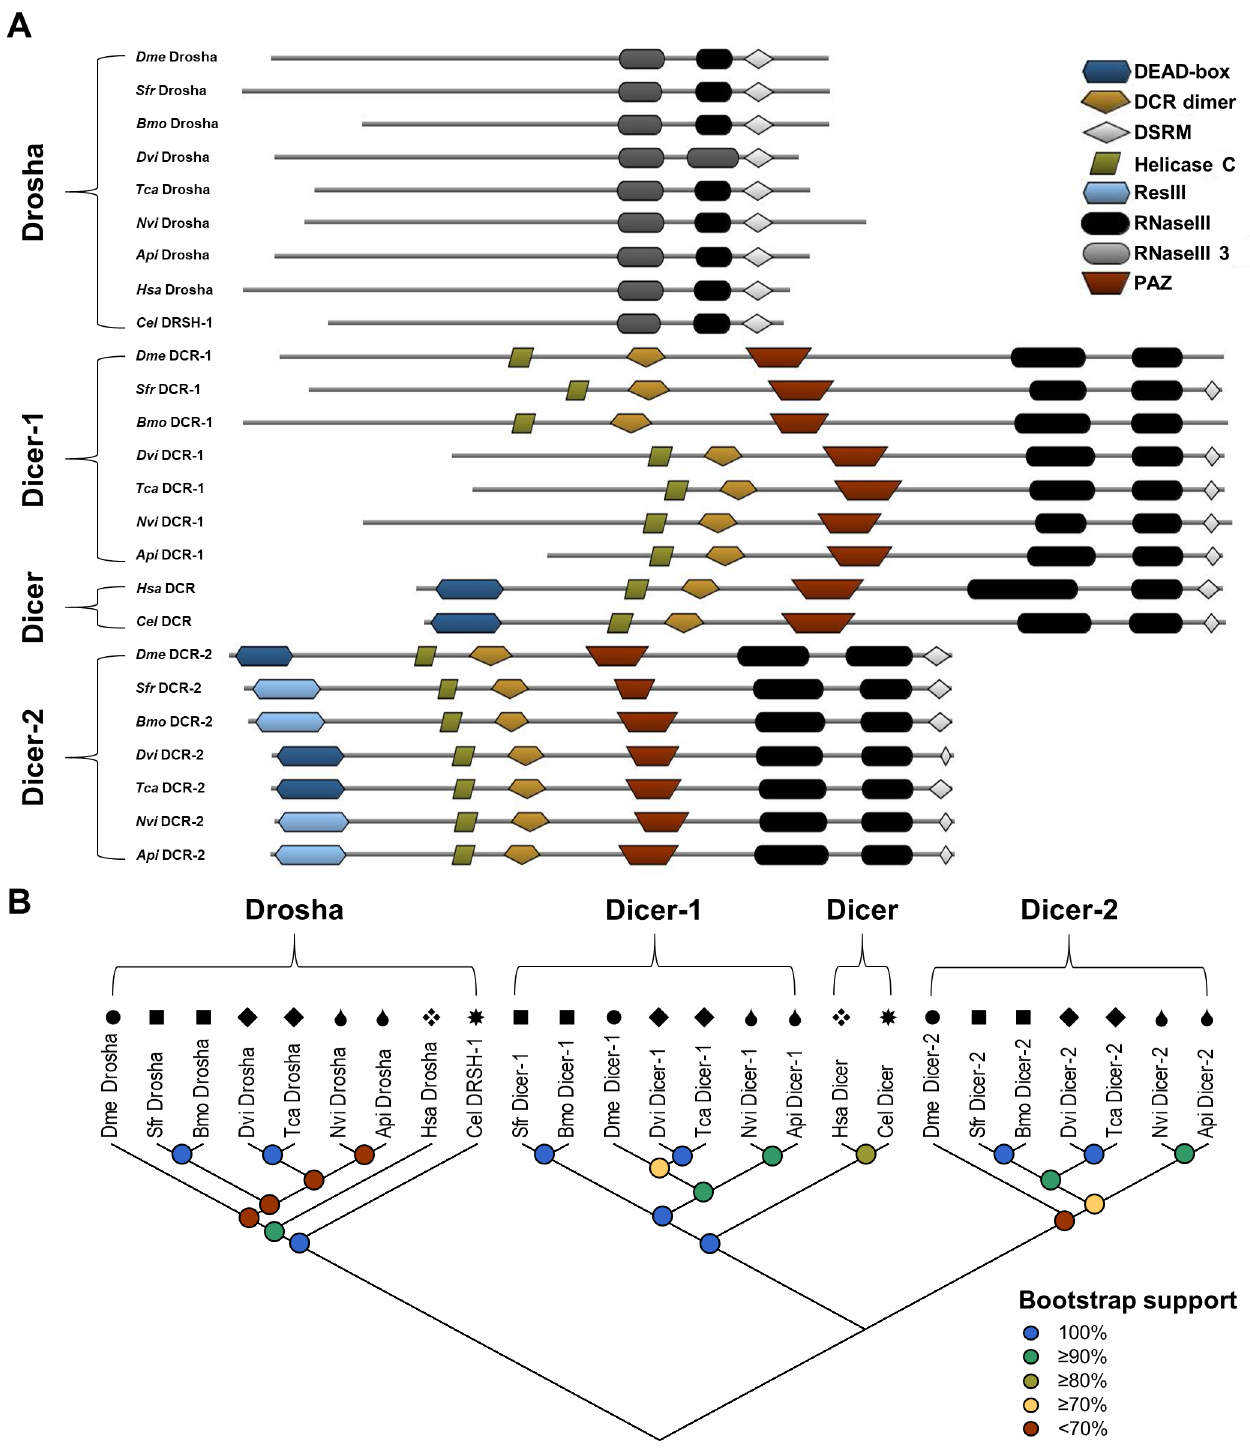
Fig 1. Properties of core mi- and si-RNA pathway RNaseIII-domain containing proteins in WCR, FAW, and SGSB. (A) The predicted protein domains encoded by the Drosha, Dicer, Dicer-1, and Dicer-2 transcripts of A . pisum ( Api : XP_003247913.1, XP_001944314.2, XP_016665103.1), B . mori ( Bmo